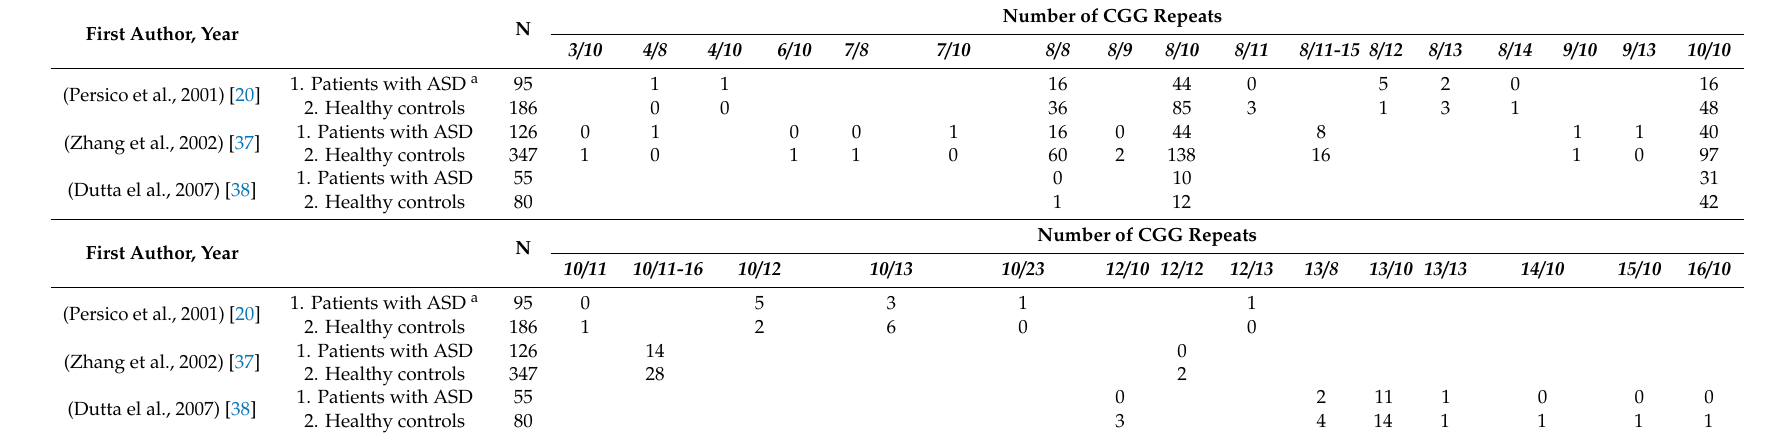
Table 1. Distribution of RELN CGG repeat genotypes.